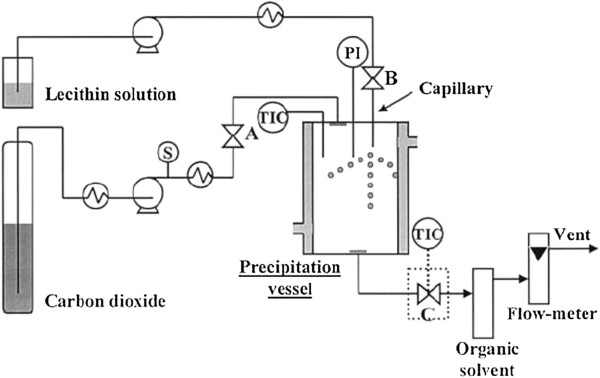
The SAS apparatus utilized for the production of liposomes[35].